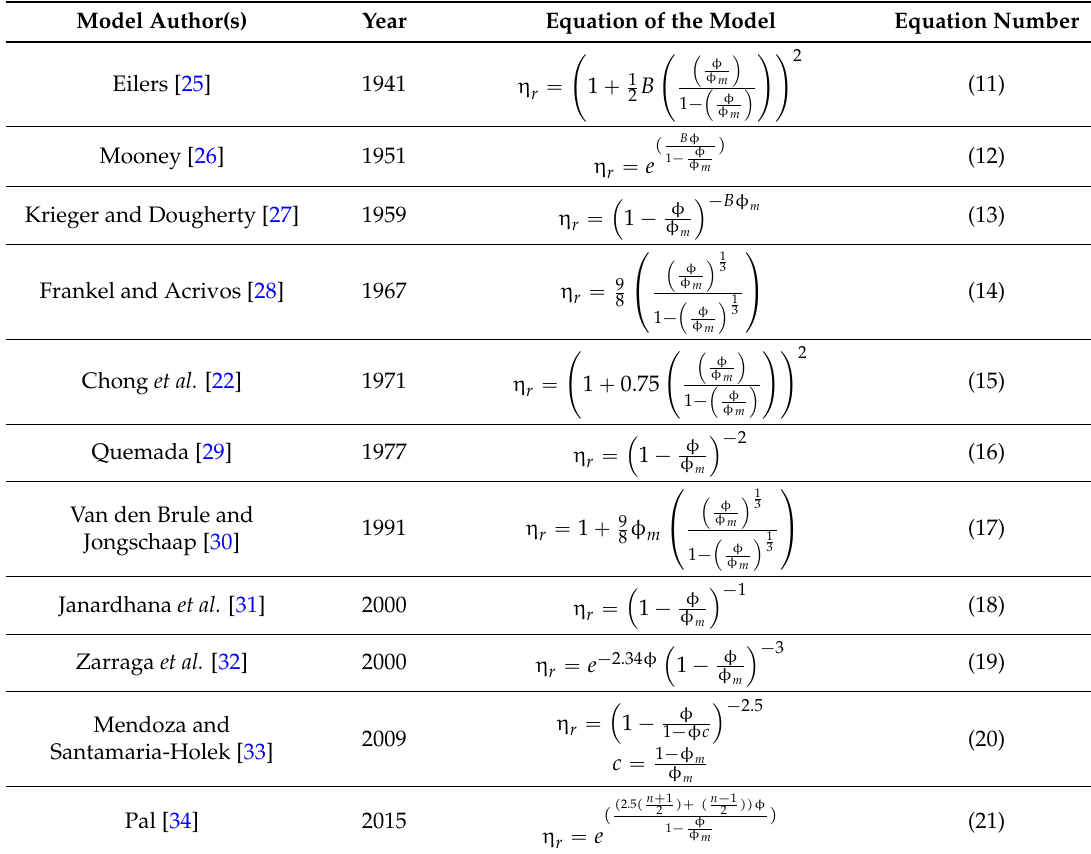
Table 2. Selected models to predict the relative viscosity ( η r ) of concentrated suspensions as a function of filler content ( φ ) and maximum packing fraction ( φ m ). Please note that B is the intrinsic viscosity like in the Einstein’s